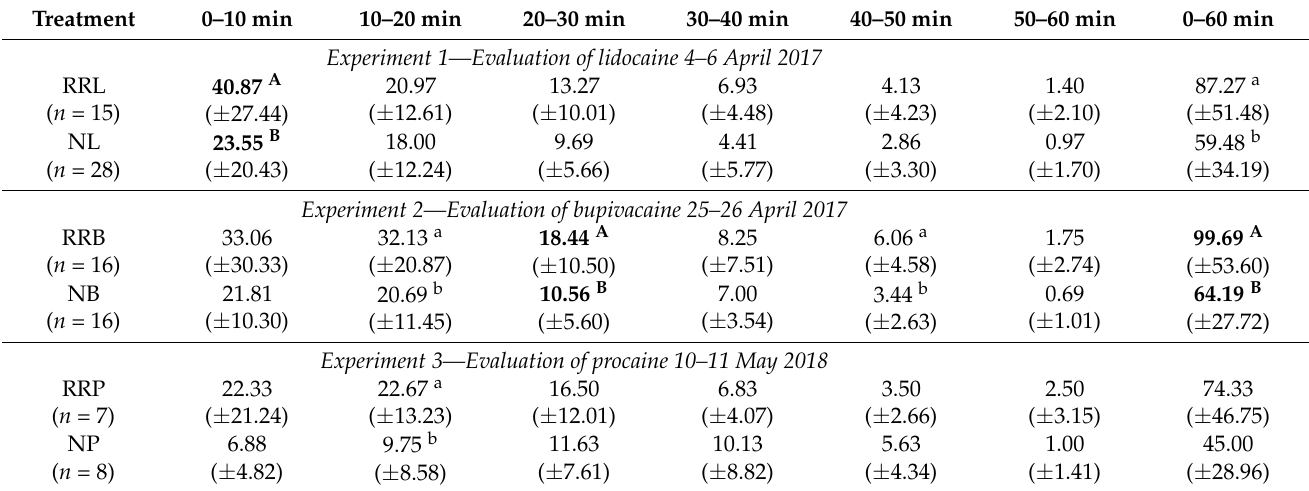
Table 3. Mean ( ± standard deviation) count of total active pain-related behaviors expressed by male lambs. Within each experiment, means within a column with differing uppercase superscripts (A, B) differ significantly ( p < 0.05), while differing lowercase superscripts (a, b) indicate a tendency to differ (0.1 > p > 0.05). RRL ring only, no local anesthetic; NL ring applied with lidocaine administered using the Numnuts ® tool; RRB ring only, no local anesthetic; NB ring applied with bupivacaine administered using the Numnuts ® tool; RRP ring only, no local anesthetic; NP ring applied with procaine administered using the Numnuts ® tool.